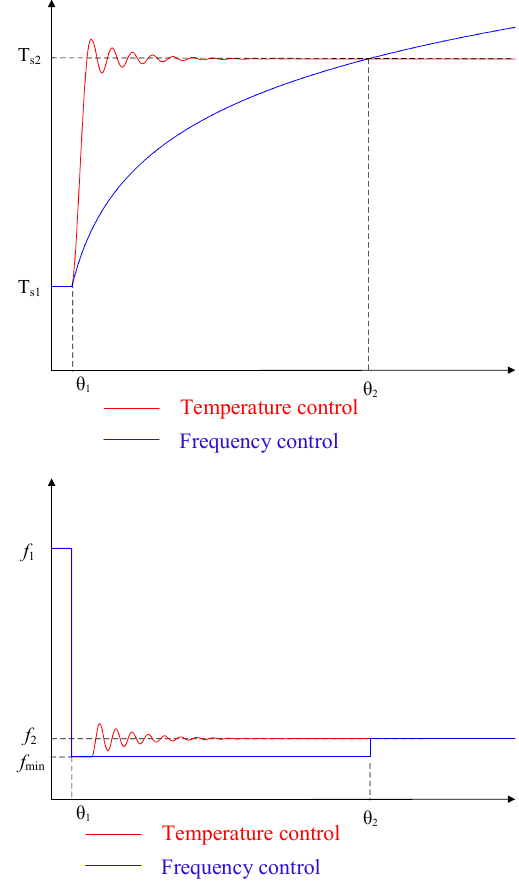
Figure 1. Schematic diagram of different control methods.